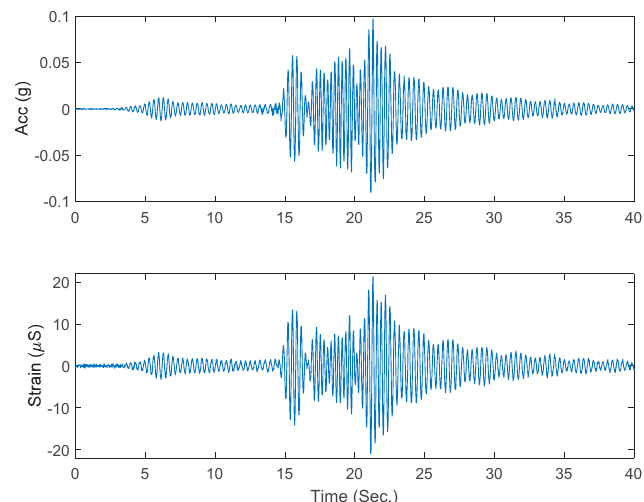
Figure 7. Acceleration and dynamic strains measurements.